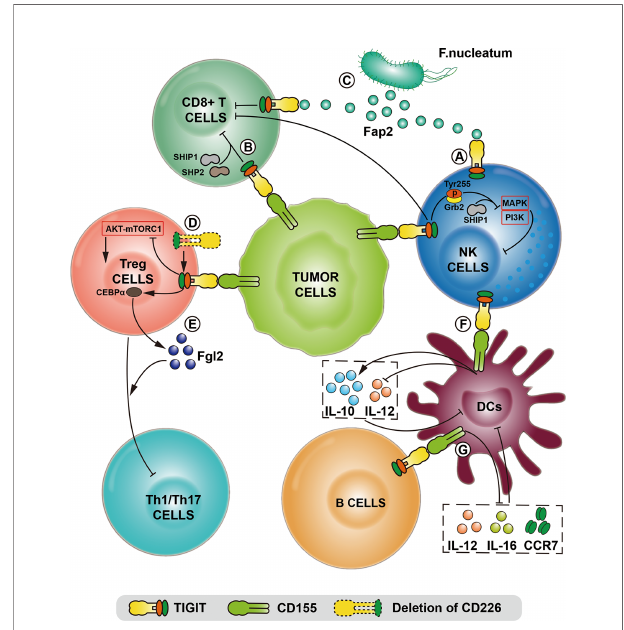
FIGURE 2 | The comprehensive mechanisms of TIGIT/CD155 axis mediated in the immune system in various models and biological contexts. (A) After TIGIT expressed on NK cells binds to CD155, the intracellular immunoreceptor (ITT)-like motif of TIGIT is phosphorylated at Tyr255 and interacts with Grb2, which terminates MAPK and PI3K signaling via recruiting SHIIP1, leading to the inhibition of NK cell function. (B) TIGIT/CD155 axis directly induces CD8+T cell exhaustion by recruiting SHIP1 and SHP2 phosphatase. (C) Tumor cells restrict NK and CD8+T cell activity using the Fap2 protein of F.nucleatum bacteria to interact with TIGIT. (D) The deletion of CD226 enhances TIGIT/CD155 signaling, thereby maintaining the immunosuppressive function of Tregs with the inhibition of the AKT-mTORC1 pathway. (E) After TIGIT/CD155 ligation, the transcription factor CEBP a promotes the transcription of the soluble effector molecule fi brinogen-like protein 2 (Fgl2), thereby the hypersecretion of Fgl2 in Tregs facilitates the suppression of pro-in fl ammatory Th1 and Th17 cells. (F) The binding of CD155 to TIGIT on dendritic cells (DC) induces the production of IL-10 and inhibits the production of IL-12, which directly leads to the DC maturation and indirectly reduces the proliferation and function of T cells. (G) TIGIT expressed on speci fi c B cell subsets binds to CD155 expressed on DC, leading to the decreased expression of IL-12, IL-16 and CCR7, thereby inhibiting the maturation and pro-in fl ammatory response of